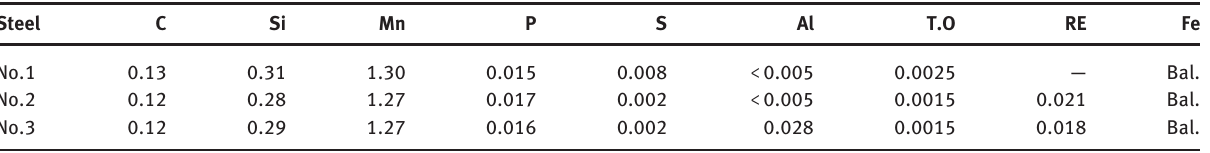
Table 1: The chemical composition of the experimental steels/mass%. Steel